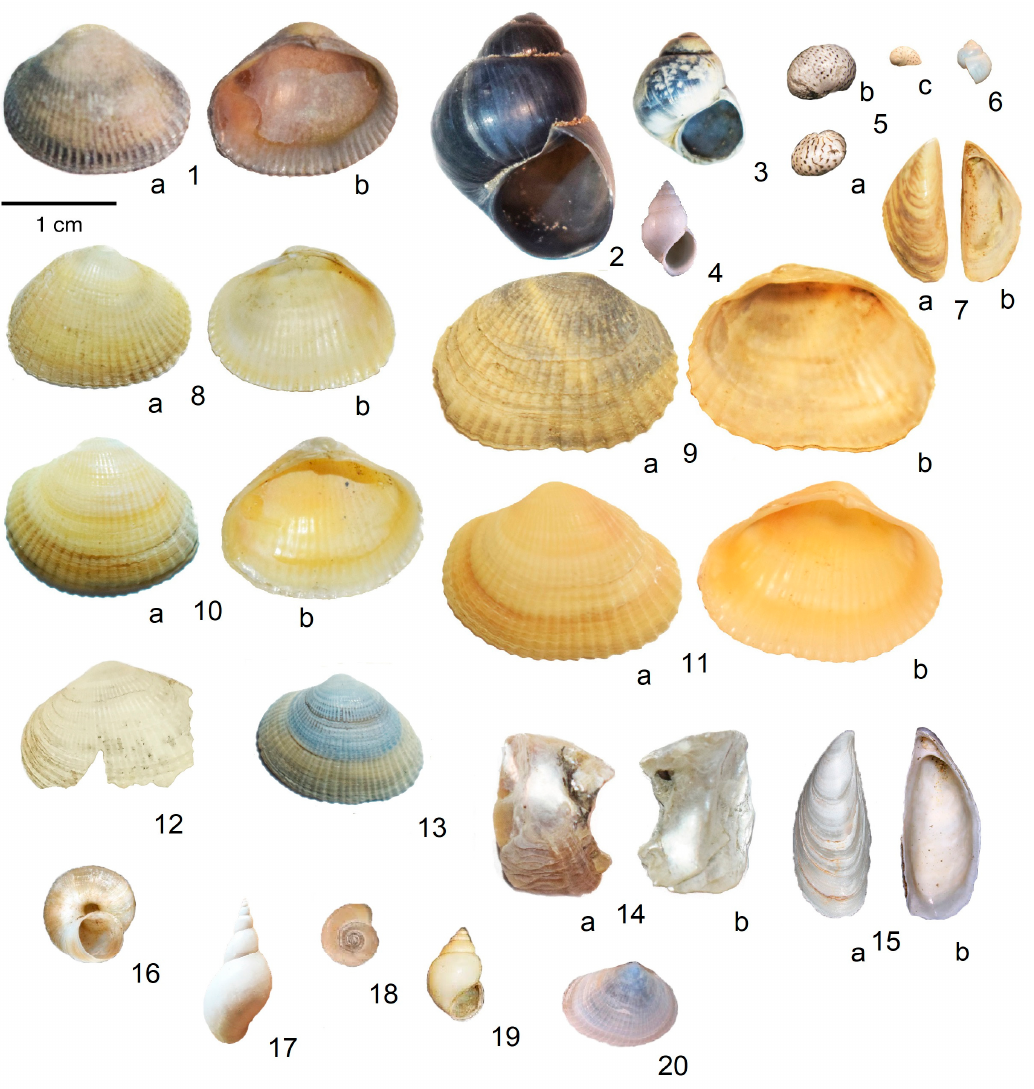
Figure 3. Mollusk fauna of the studied Rybachya core ((a) outer view, (b) internal view). (1), (8), (10), (13) Monodacna caspia ; (2), (3) Viviparus viviparus ; (4) Clessiniola variabilis ; (5a, b, c) Theodoxus pallasi ; (6) Abeskunus brusinianus ; (7) Dreissena polymorpha ; (9) Hypanis plicata ; (11) Monodacna angusticostata ; (12) Didacna sp.; (14) Unio sp.; (15) Dreissena caspia ; (16) Valvata piscinalis ; (17) Lymnea stagnalis ; (18) Planorbis planorbis ; (19) Bithynia tentaculata ; (20) Adacna vitrea . Scale bars 1 cm. Assemblage III: The interval 0.80–0.30 m contains only detritus, while samples from the core upper part (0.30–0.20 m) interval contain a prevalence of Monodacna caspia , numerous Monodacna angusticostata (Borcea, 1926), and Dreissena caspia , with rare specimens of Hypanis plicata , Bithynia tentaculata , Theodoxus pallasi , Adacna vitrea (Eichwald, 1829), Clessiniola variabilis , and small fragments of Didacna